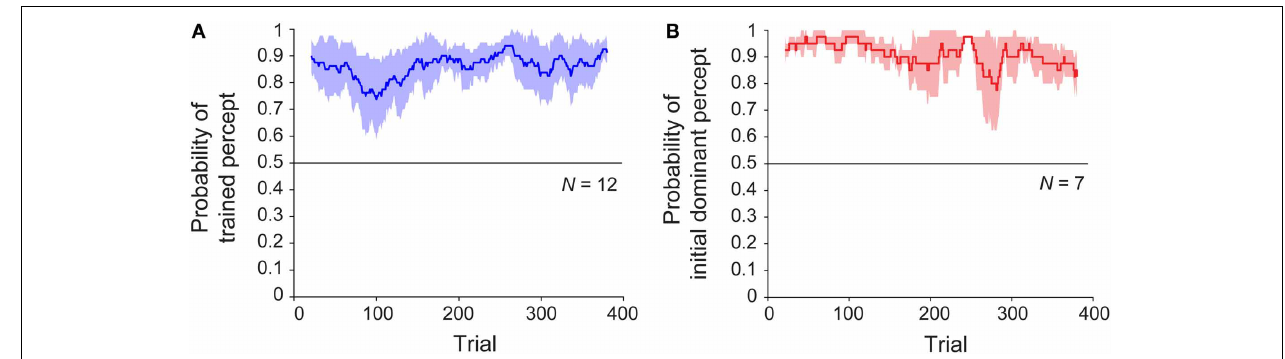
FIGURE 3 | Time course of median perceptual bias across subjects throughout the block for observers in (A) trained ( N = 12) and (B) untrained ( N = 7) groups. Colored lines represent group median